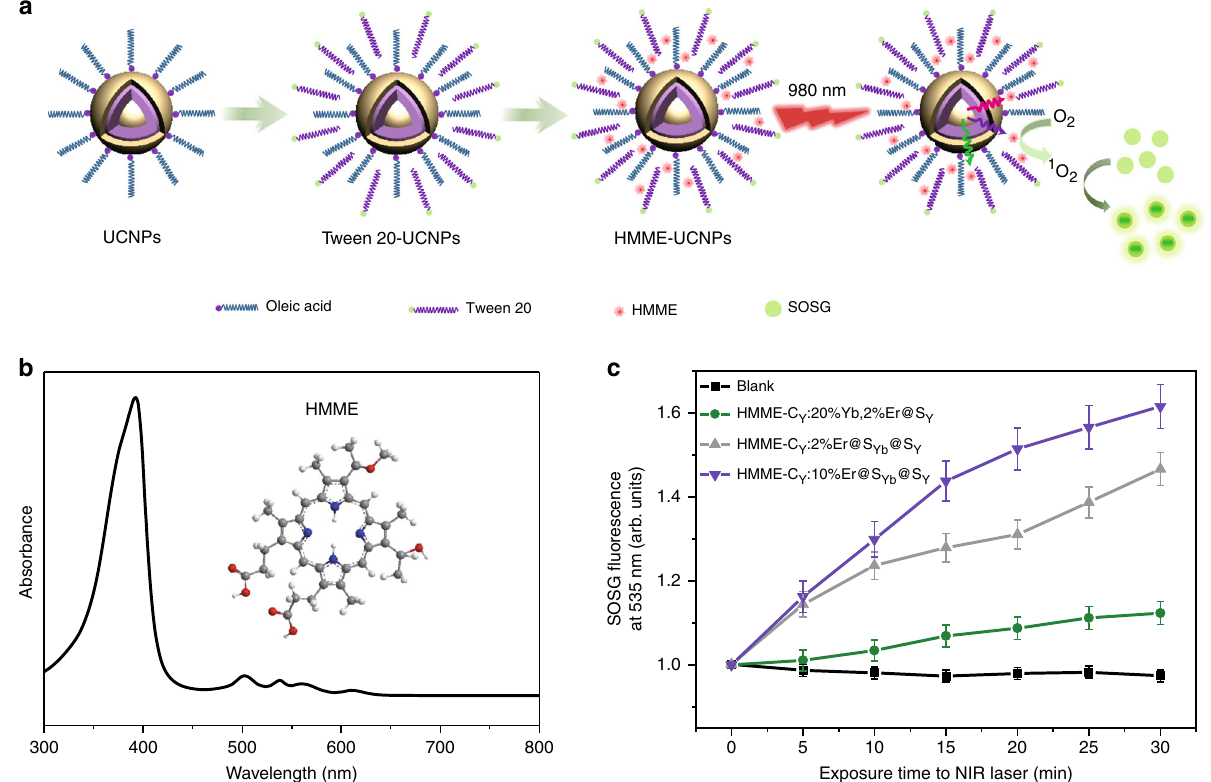
Fig. 5 Singlet oxygen production activity upon exciting the UCNPs. a Schematic diagram for loading hematoporphyrin monomethyl ether (HMME) and producing 1 O 2 on the UCNPs. b Structural formula and absorption spectrum of HMME. c Comparison of 1 O 2 production under 980 nm irradiation (24 W cm − 2 ) as determined by the augmentation of singlet oxygen sensor green reagent (SOSG) fl uorescence at 535 nm. For C Y :20%Yb, 2%Er@S Y , d SY = 10.5 ± 0.8 nm. For C Y :Er@S Yb @S Y , d SYb = 8.3 ± 0.7 nm, d SY = 2.3 ± 0.1 nm. The error bars represent the standard deviation of three trials. Source data are provided as a Source Data fi